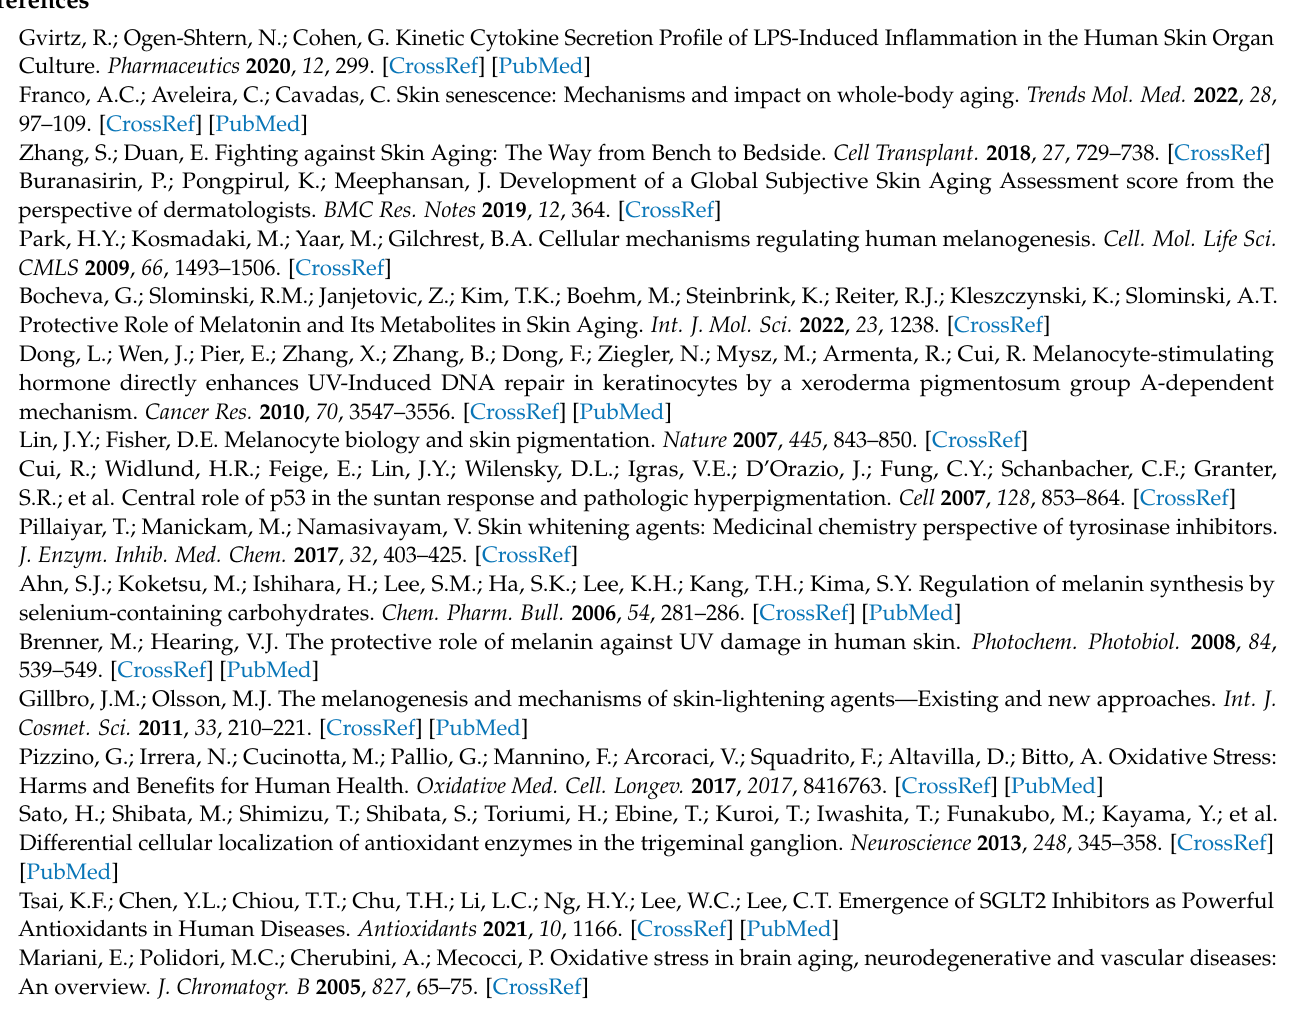
Figure S2: 1 H NMR spectra for PCA-C4; Figure S3: 1 H NMR spectra for PCA-C5; Figure S4: 1 H NMR spectra for PCA-C6; Figure S5: 1 H NMR spectra for PCA-C7; Figure S6: 1 H NMR spec- tra for PCA-C12; Table S1: PCA derivatives reduce α -MSH-mediated melanin synthesis in B16 melanoma